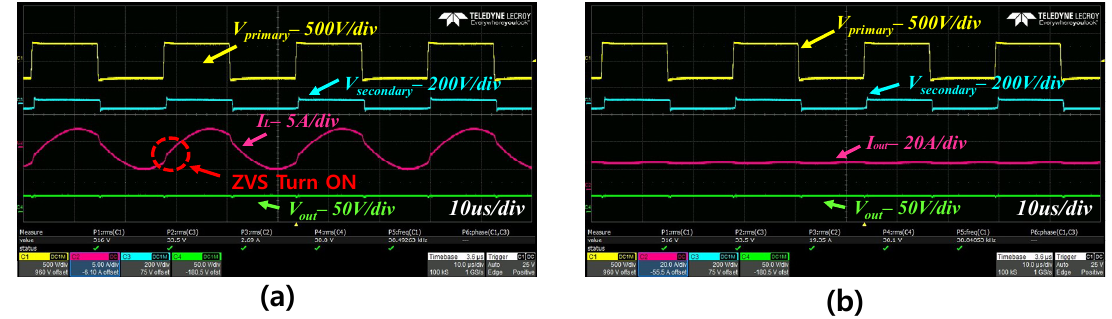
Figure 13. The LIB CV (Constant Voltage) mode charging waveform; ( a ) Vprimary, Vsecondary, IL, Vout; ( b ) Vprimary, Vsecondary, Iout, Vout.